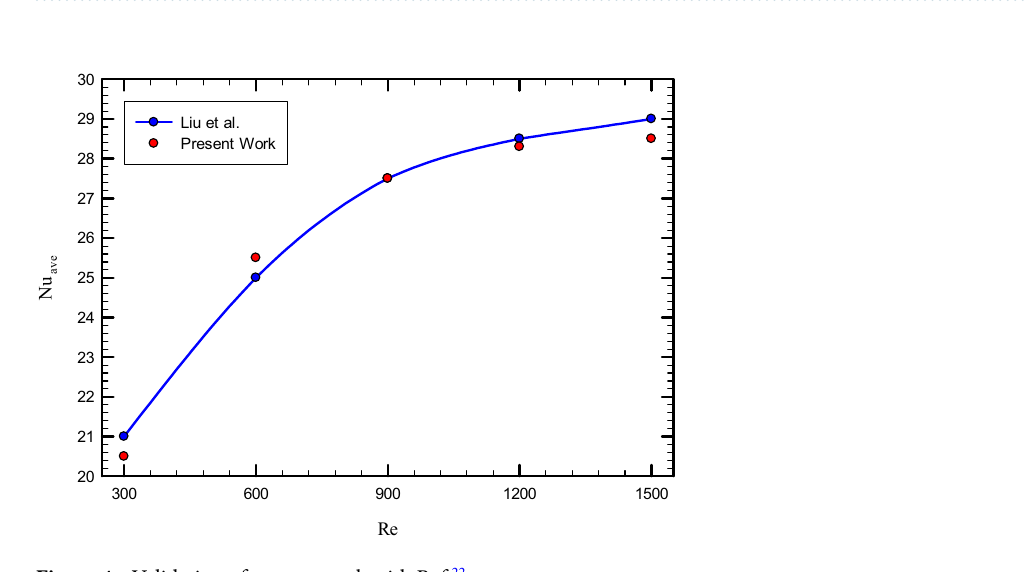
Figure 4. Validation of present work with Ref. 22